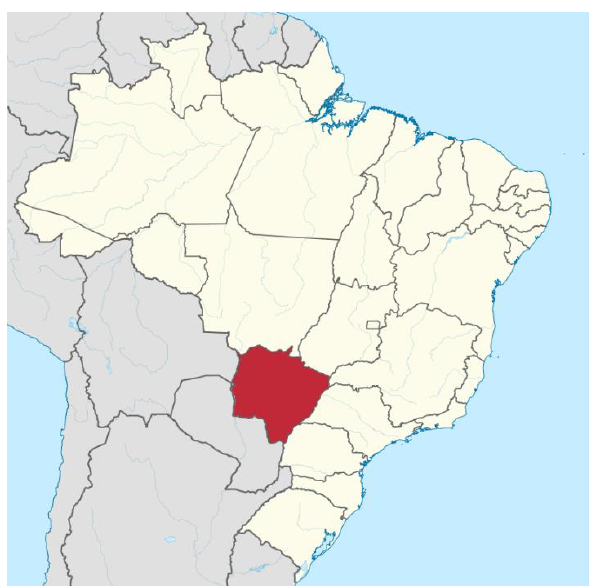
Figure 1. State of Mato Grosso do Sul in which the property studied was located, within the Center-West region of Brazil.